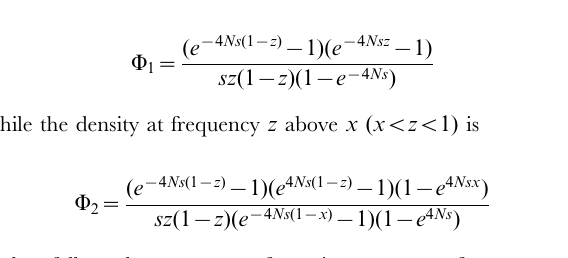
Figure 6. Bootstrap distribution of normalized difference between NC statistic on missense and synonymous variants for derived allele count 2 and 3. Vertical red bars indicate 95% confidence intervals. For presentation, panels have been aligned along the X axis.